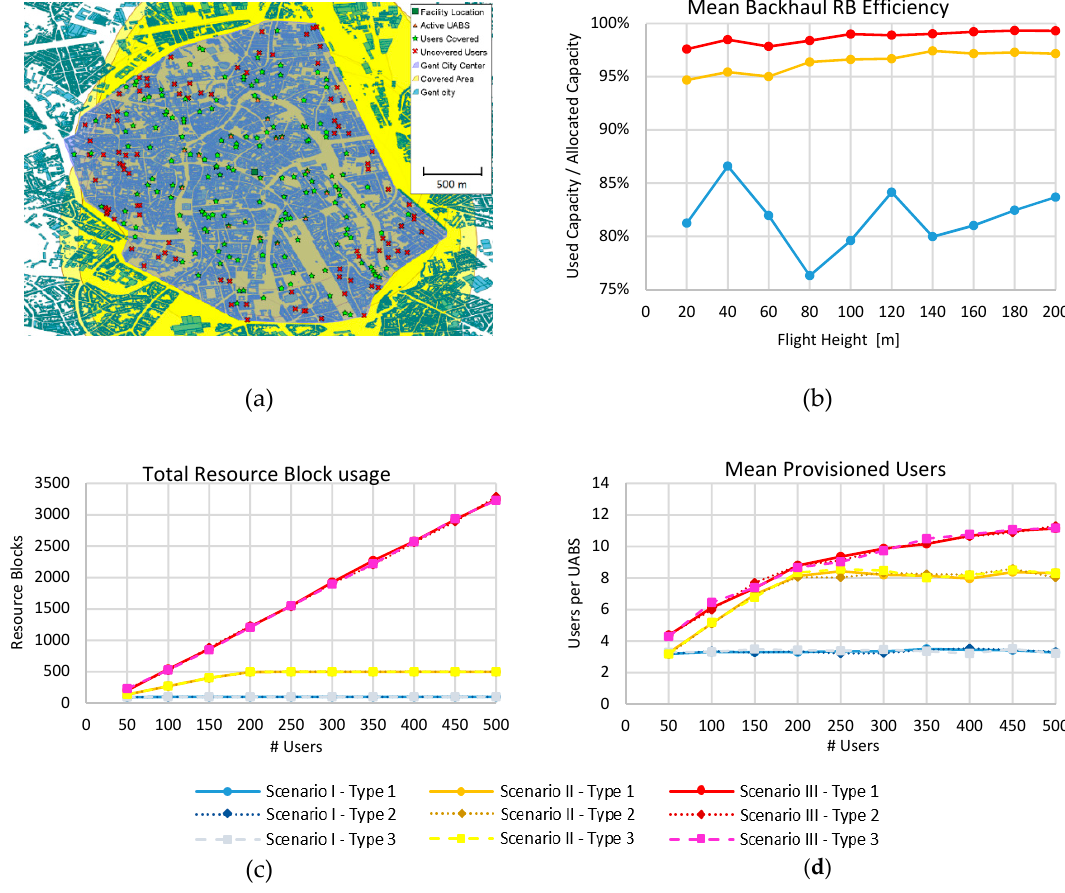
Figure 7. Performance of 60 GHz band and comparison with 3.5 GHz scenarios. ( a ) Coverage using the 60 GHz band. ( b ) Backhaul resource block (RB) efficiency. ( c ) Resource block used. ( d ) Provisioned users.